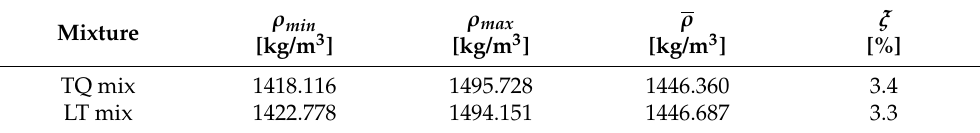
Table 4. Densities in the dry state of the nine specimens made with the TQ mix, and the nine specimens made with the LT mix (for the meaning of symbols, see Equation